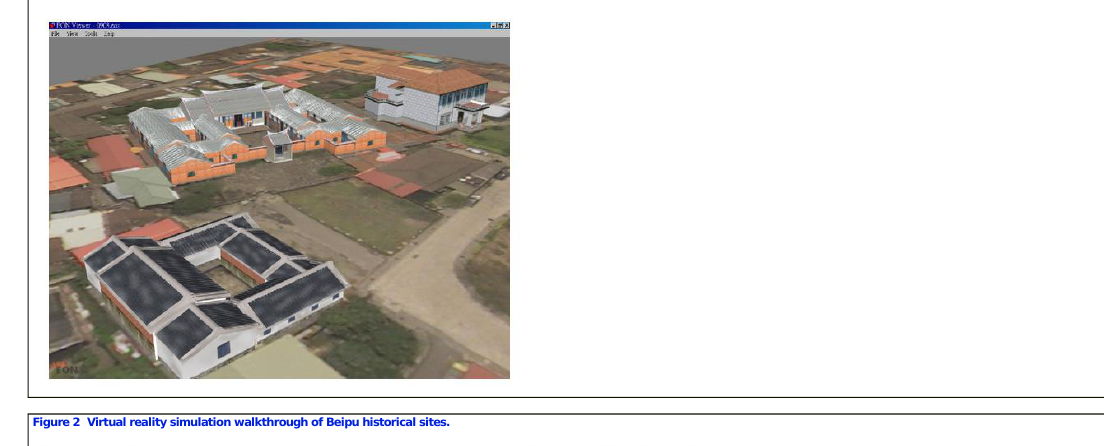
Figure 1 3D models overlaid on satellite image of Beipu Township, Hsinchu county, Taiwan.